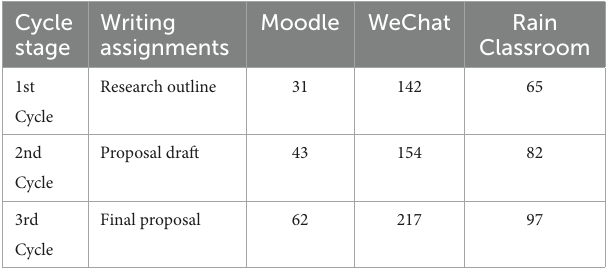
TABLE 3 E-feedback collected in three